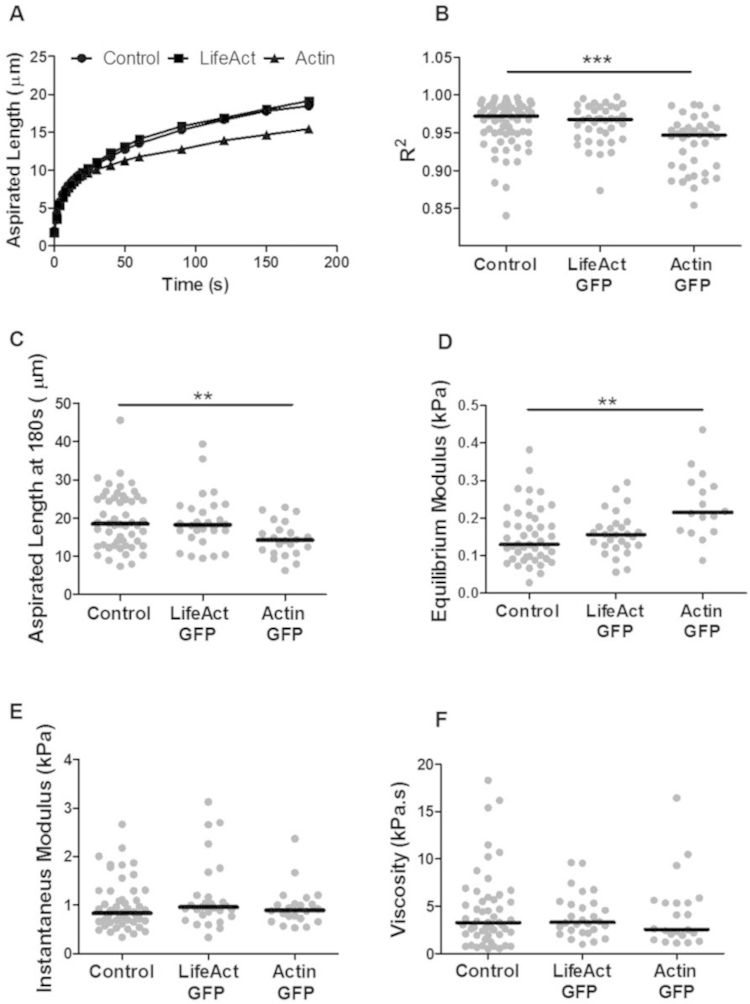
LifeAct-GFP does not interfere with cell biomechanical properties. (A) Plots of median aspirated length versus time for control, LifeAct-GFP and actin-GFP hMSCs. hMSCs transfected with actin-GFP exhibit a shorter aspirated length compared to control cells. Corresponding plots showing (B) fitting parameter R2, (C) aspirated length at t=180 s, (D) equilibrium modulus, (E) instantaneous modulus and (F) viscosity. Data pooled from two independent experiments. (**: p<0.01, ***: p<0.001 Mann–Whitney U test; see Table 1 for n values).